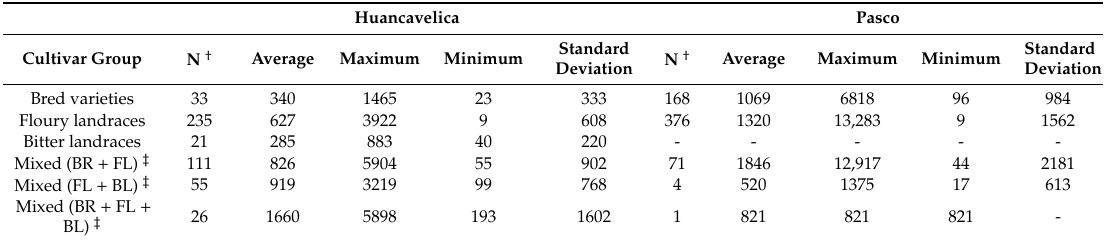
Table 10. Average area (m 2 ) per field for exclusive and mixed fields by cultivar group and landscape. Huancavelica Pasco Cultivar Group N